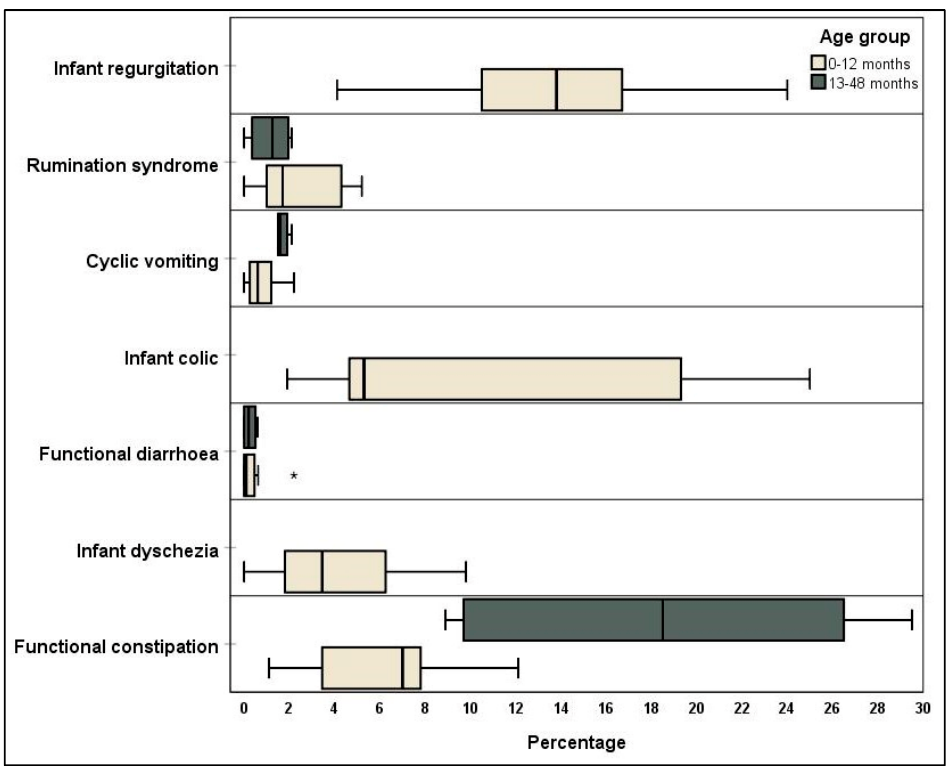
Figure 1. Percentage incidence of specific Rome IV criteria for children up to the age of four years. *: outlier